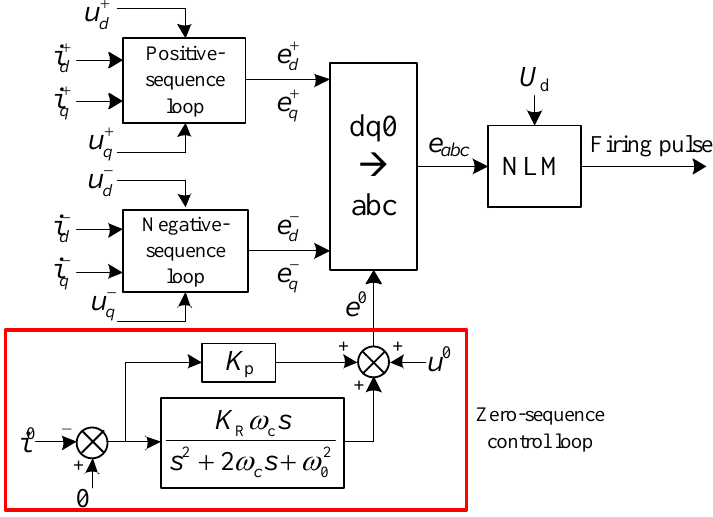
Figure 6. Optimized control strategy of MMC.